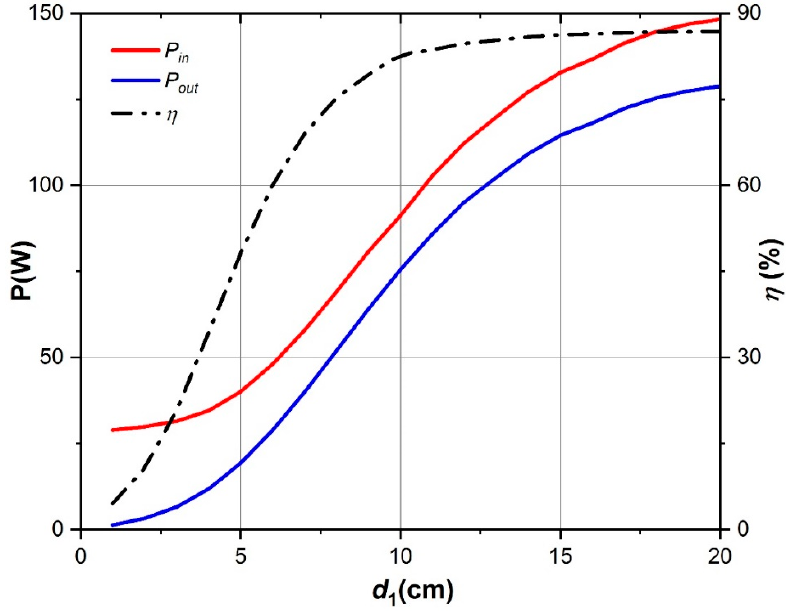
Figure 9. Power transfer and efficiency versus the distance d 1 .